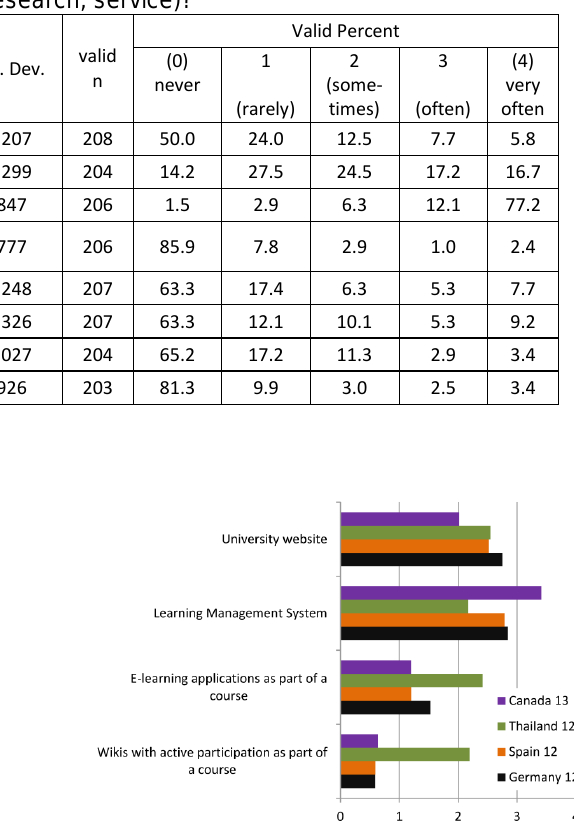
Table 12. Instructors’ responses to the question: How often do you use the following for your academic work